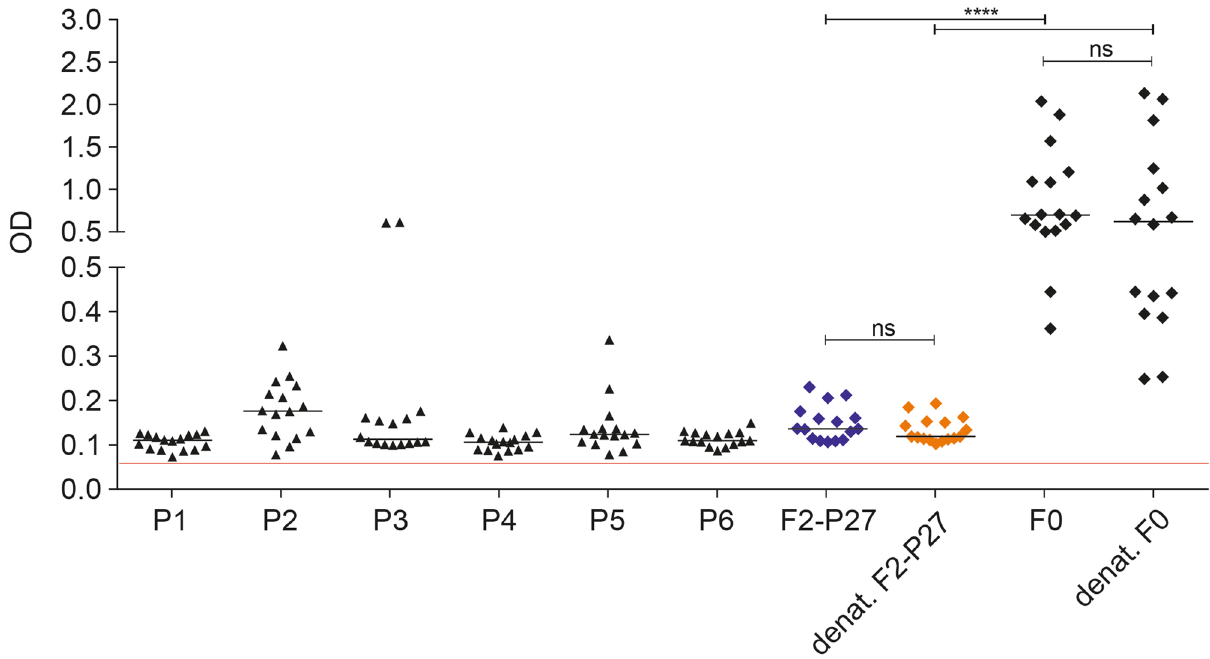
Figure 5. Effects of denaturation on human IgG responses to recombinant F2-P27 and F0. Shown are IgG levels (y-axis: optical density values) as scatter plots (16 adult individuals) specific for native (dark blue) and denatured (orange) recombinant F2-P27 subunit, native and denatured F0 and native F2-derived synthetic peptides (P1– P6) (x-axis). Horizontal lines within plots indicate median values. The cut-off (mean of buffer control plus three times standard deviation) is indicated by a red line. Significant differences of antibody responses are indicated: ns (not significant); *p < 0.05; **p < 0.001; ***p <